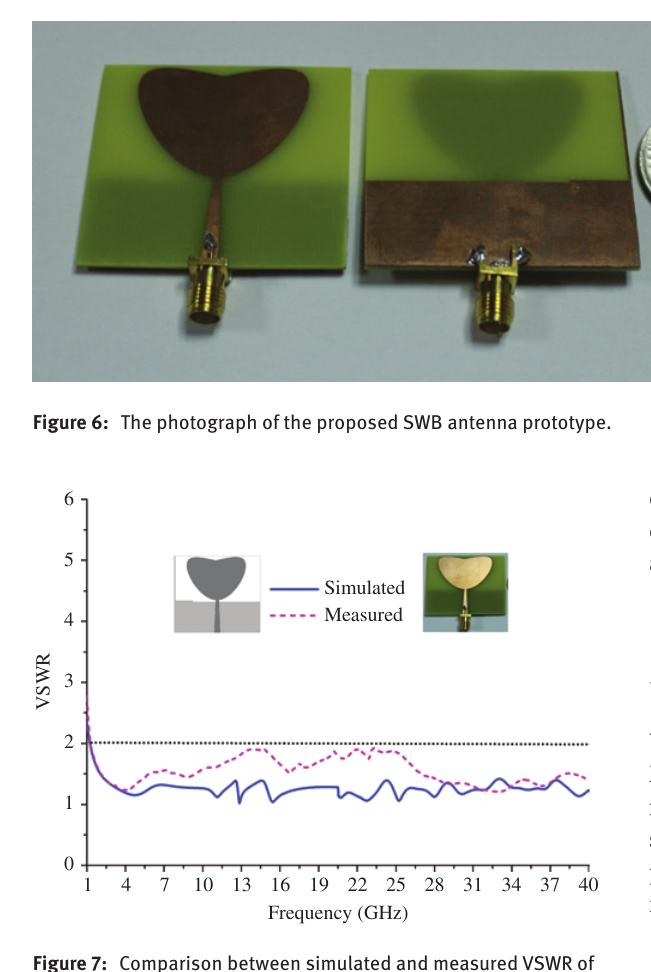
Figure 7: Comparison between simulated and measured VSWR of the proposed antenna.